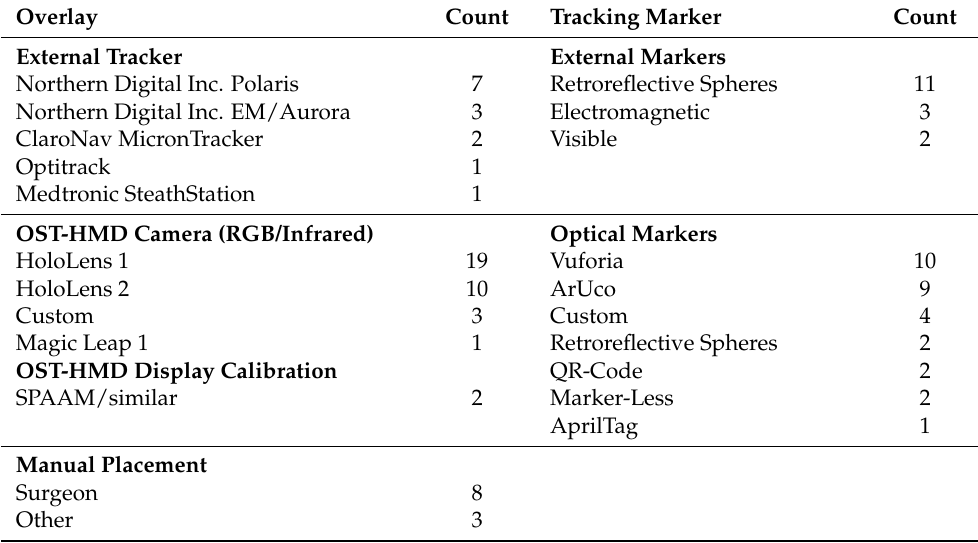
Table 4. Papers categorized by the overlay type used. External trackers (surgical navigation suites) were used in conjunction with an optical see-through head-mounted display to co-locate the headset with relevant tracked surgical tools in frame. We indicate the frequency of commercial tracking system usage and the type of tracking marker